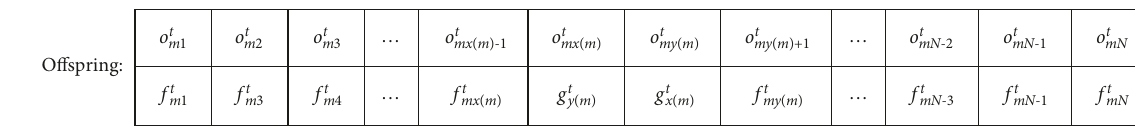
Figure 7: The offspring gene sequence containing the variant gene. Table 2: Travelers’ parking demand under the “reservation priority” mode.